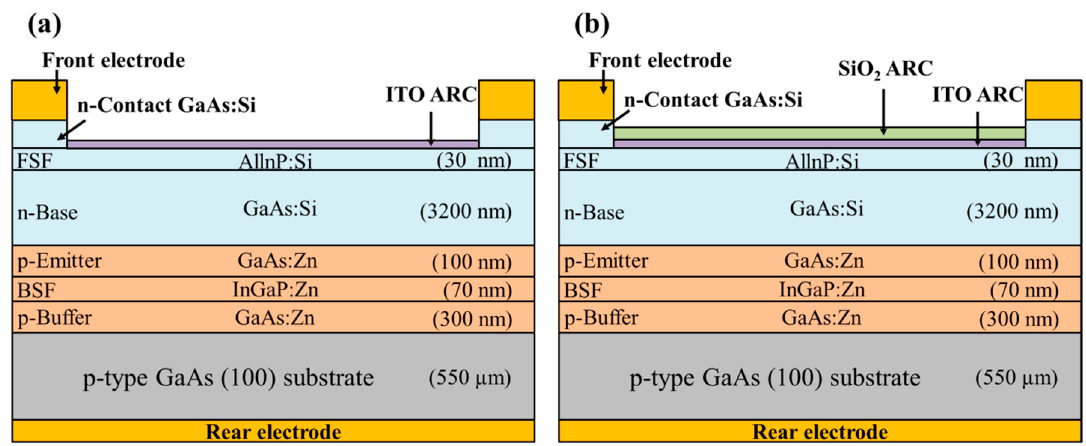
Figure 2. Schematic diagrams of bare-type GaAs single-junction solar cells coated with antireflection layers of ( a ) ITO and ( b ) ITO/SiO 2 .